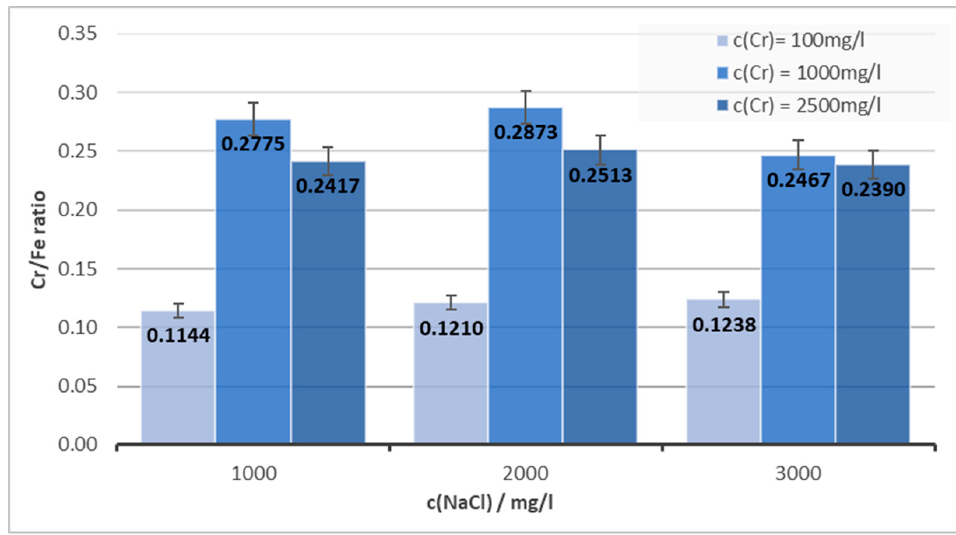
Figure 4. The Cr/Fe ratio’s dependence on NaCl concentration for pH = 6 and I = 1 A. Another observation is the dependence of the Cr/Fe ratio on the pH of the solution from which the product was created. As can be seen in Figure 5, for a concentration of Cr 1000 mg/and a concentration of NaCl 3000 mg/L, the pH of the solution signi fi cantly a ff ects the composition of the fi nal solid product and the best Cr/Fe ratio in the product is for pH = 6. At this pH, an approximately 30% percent higher Cr/Fe ratio was achieved compared to pH 4.5 or 8 at a current of 0.1. The observation was similar for currents 0.5 A and 1 A, although with a percentage di ff erence of approximately 20% and 16%. However, when high current intensities (2 A) were used, this positive e ff ect was lost and, as indicated by the data in Figure 5, pH did not in fl uence the Cr/Fe ratio.